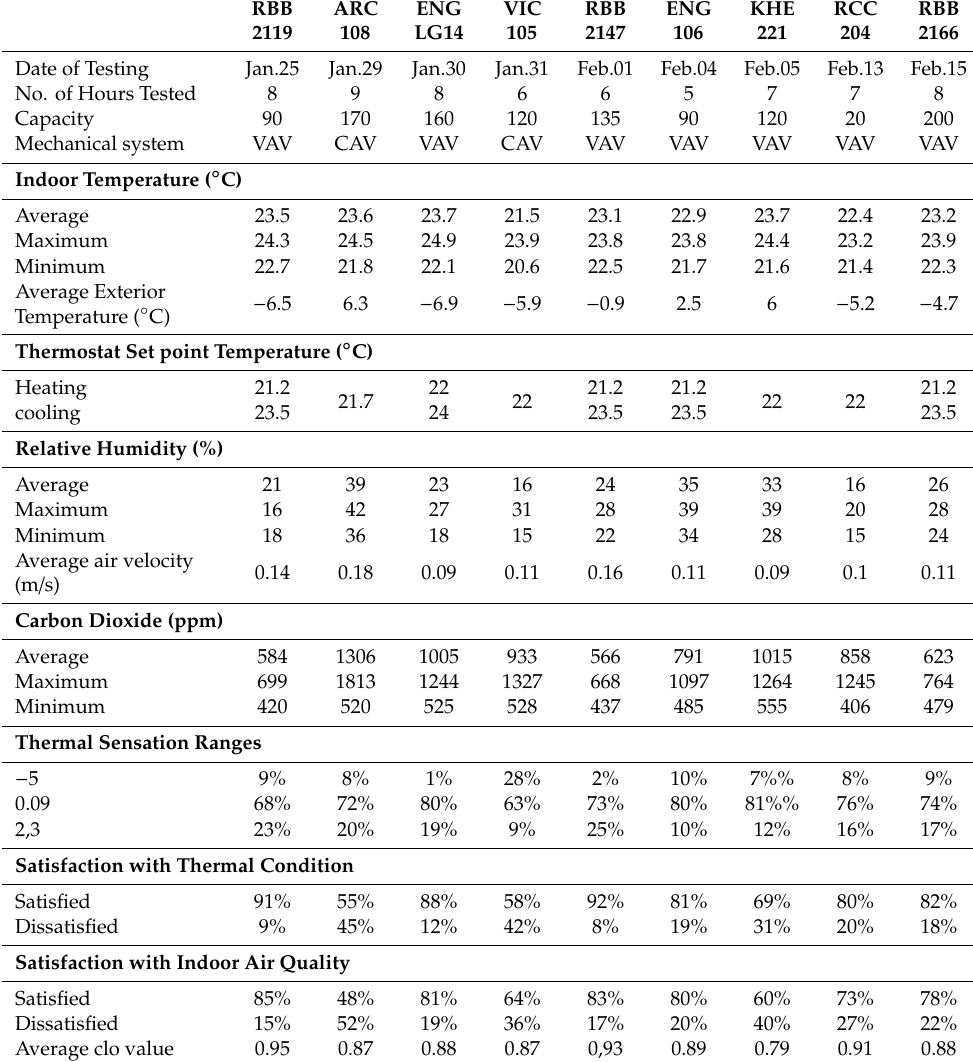
Table A1. Measurements Result of the Classrooms